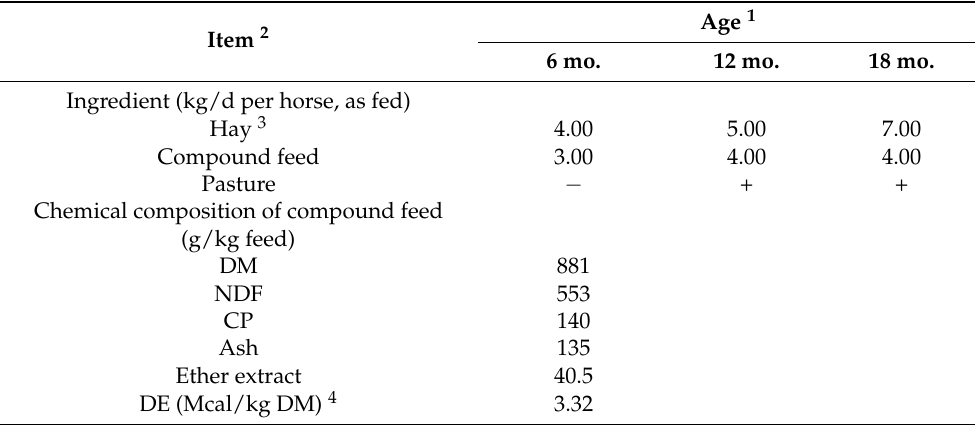
Table 1. Rations for the growing horse across different growth stages. Item